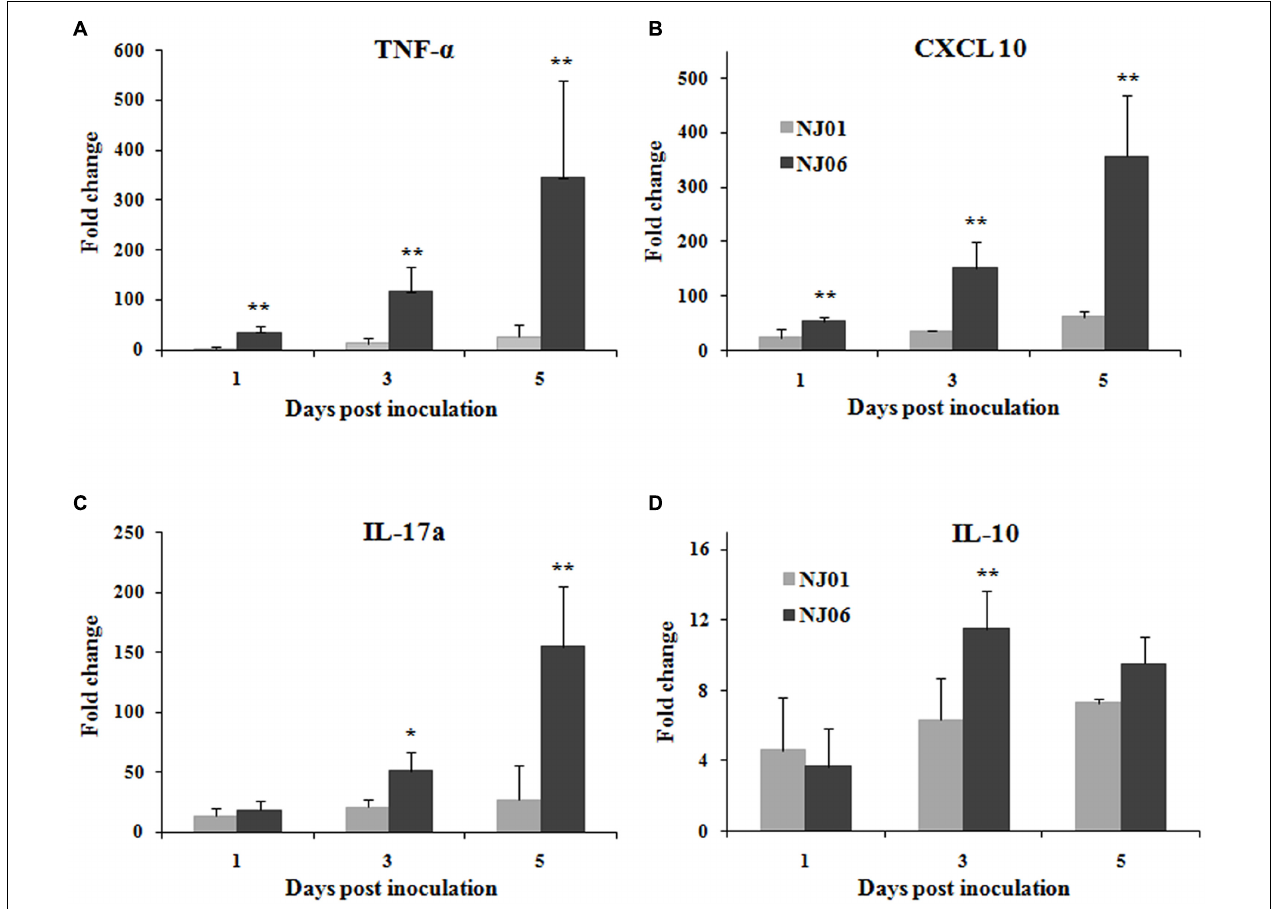
FIGURE 5 | Inflammatory cytokines response in mouse lungs. Groups of five mice were intranasally inoculated with 10 5 ELD 50 of NJ06 or NJ01 virus, and the expression of these cytokines, TNF- α , IL-1 β , IL-8, and IL-10, was measured in the mouse lungs at the indicated times by Quantitative real-time PCR (qRT-PCR). Each cytokine expression was normalized to the expression of β -actin, and is presented as the fold change relative to the level of the mock group. The mean fold change of each group is shown, with error bars representing the SD. ∗ indicates p < 0.05 and ∗∗ indicates p < 0.01 compared with the NJ01 virus infection